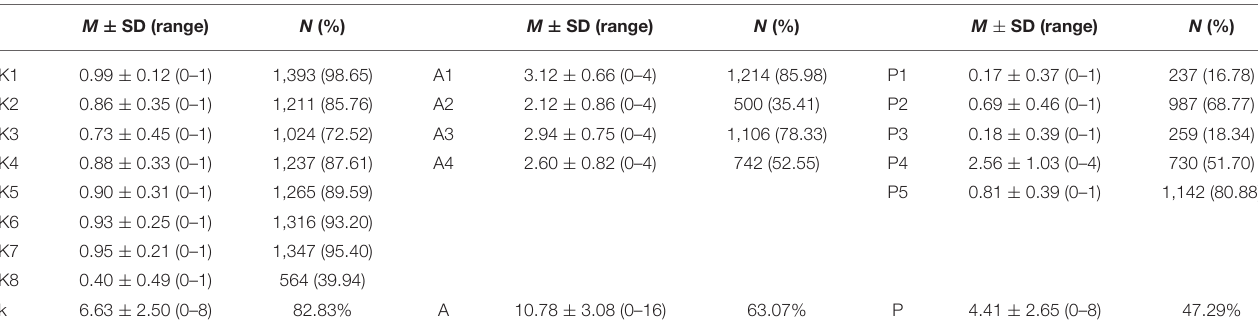
TABLE 2 | Descriptive statistics for influenza vaccine-related knowledge, attitudes, and practice (KAP). M ± SD